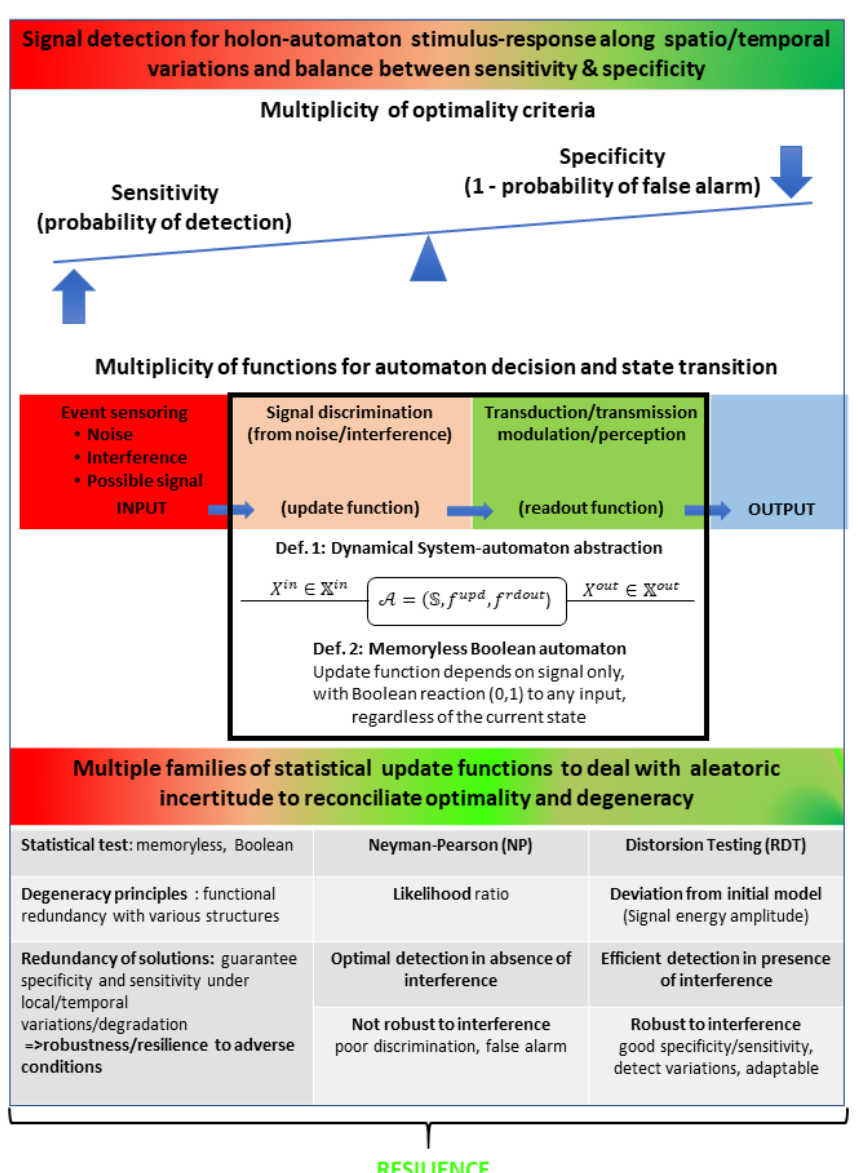
Figure 2: Automaton communication based on a multipliticy of criteria for signal detection . Facing a multiplicity of events and interference fluxes (schematized here by a superposition of colors), a discrete dynamical system (a biological holon, mathematically modeled as an automaton) should use a multiplicity of criteria to balance its performance and potential optimality, in terms of signal detection (sensitivity or P det ) vs. false alarm avoidance (specificity or 1 according to the changing environment and context of the signal detection. This balance can be sought by resorting to a multiplicity of statistical models, functions and structures. The signal detection on the basis of an input can be abstracted by an “update function” aimed at discriminating the signal from interference and noise. The outcome of the update function updates the holon state, which in turn triggers the transduction / transmission of a readout signal via a readout function. The automaton internal cascade of treatments thus allows for the holon action and the transmission of an external signal to other holons. The table at the bottom of the figure benchmarks the NP update functions and the RDT update functions by comparing the respective criteria they